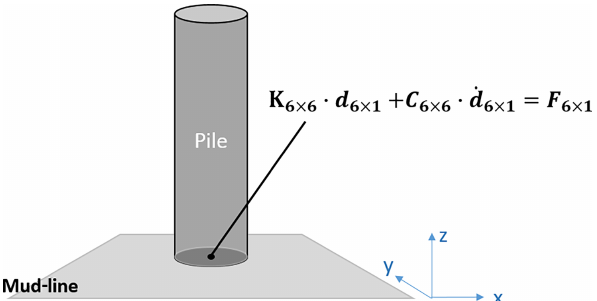
Figure 5. Model 3 applies a stiffness matrix and a damping matrix at the mud-line node to model the soil-foundation response.